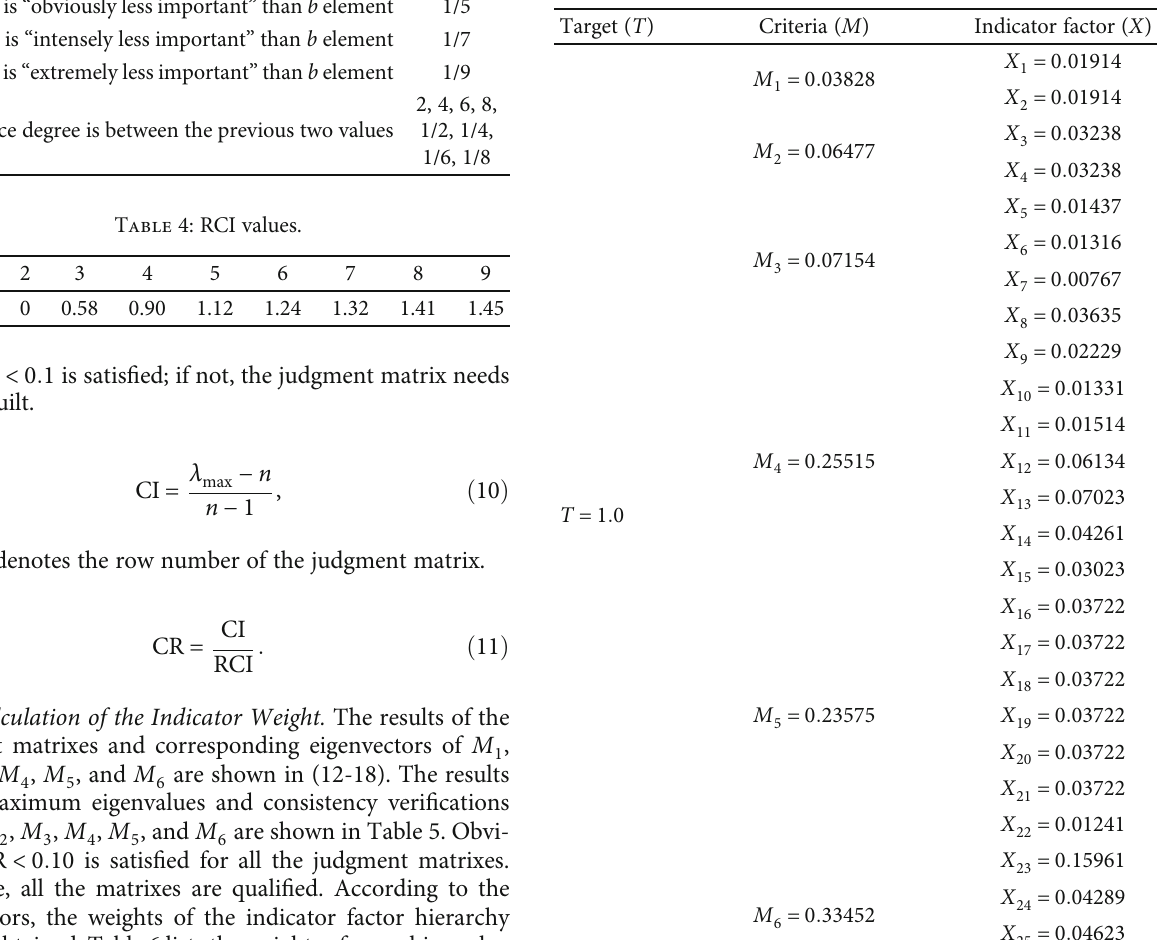
Table 6: Weights of every hierarchy in the AHP